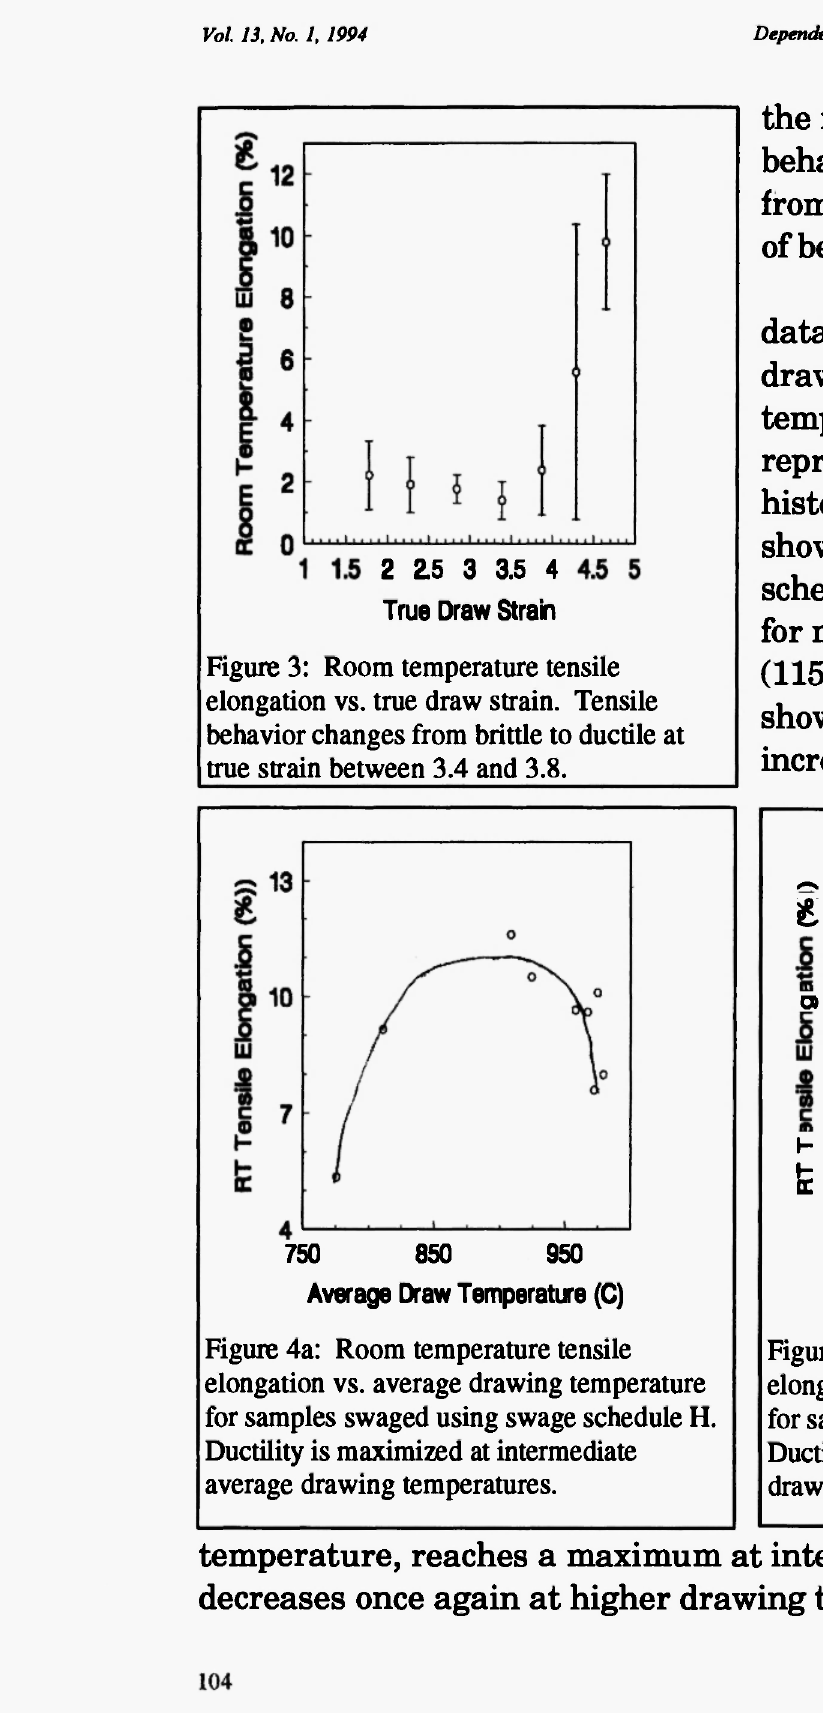
Figure 4b: Room temperature tensile elongation vs. average drawing temperature for samples swaged using swage schedule L. Ductility is maximized at intermediate drawing